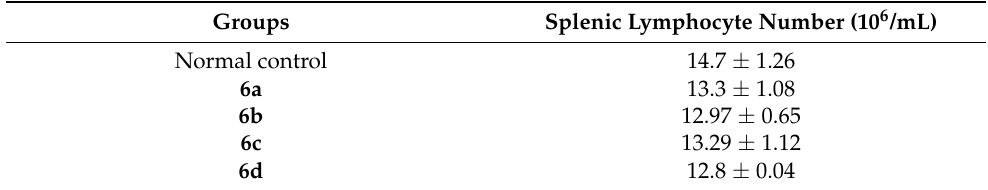
Table 6. Effect of indoloquinoline derivatives on splenic lymphocyte number in the spleen of normal mice.